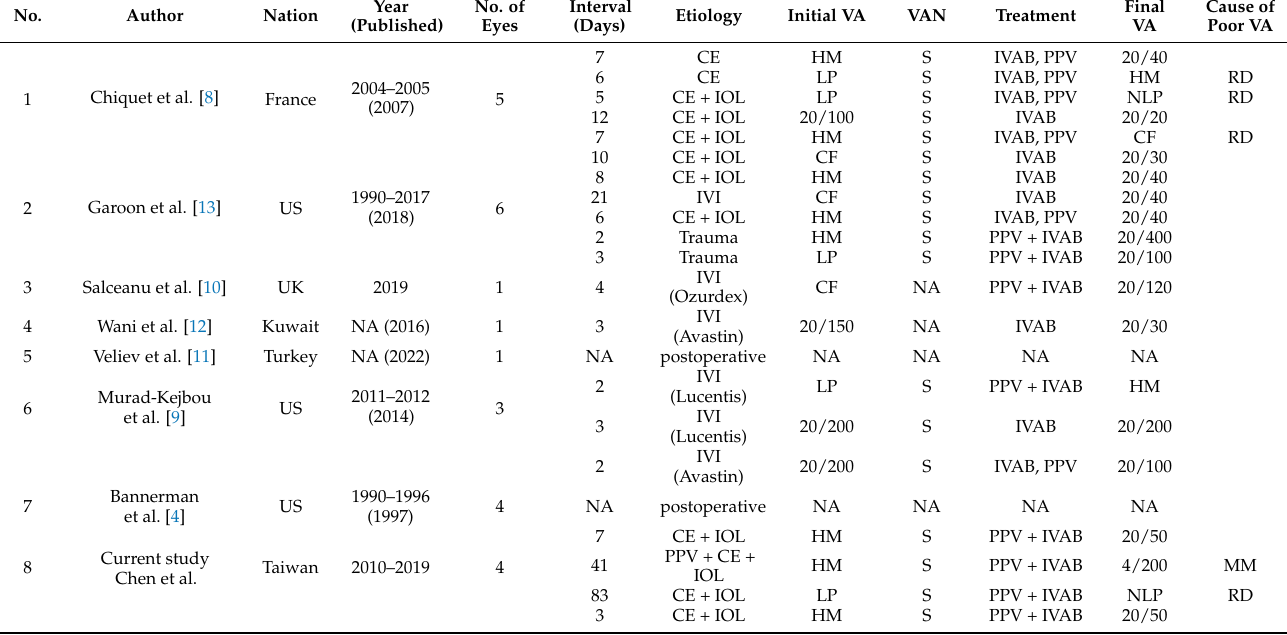
Table 3. Comparisons of published and current studies of Staphylococcus lugdunensis